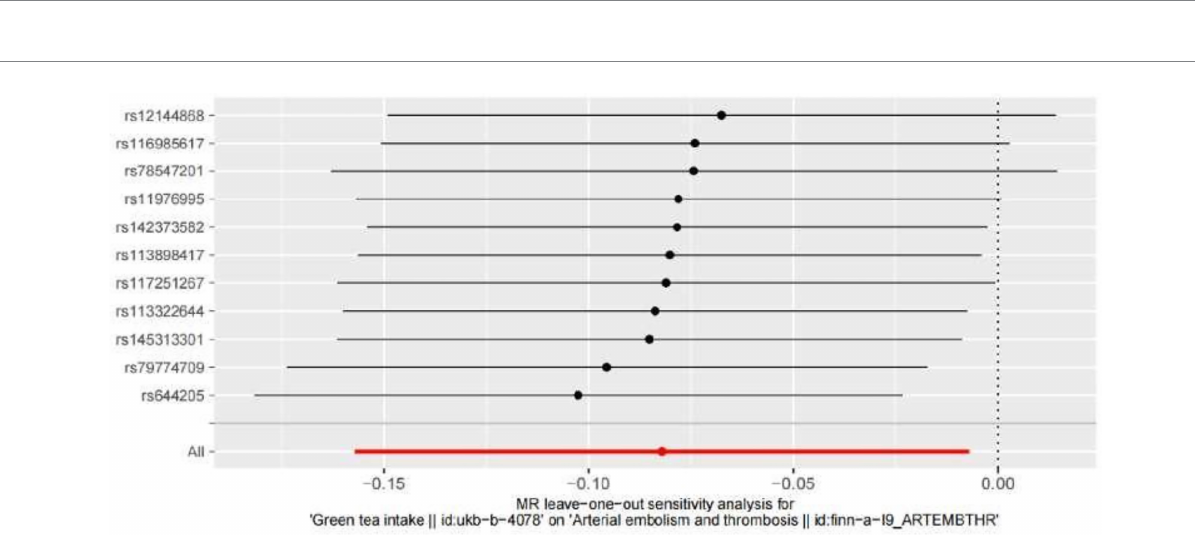
FIGURE 5 Leave-one-out plot to visualize the causal effect of hypertension on the risk of ED when leaving one SNP out MR indicates Mendelian